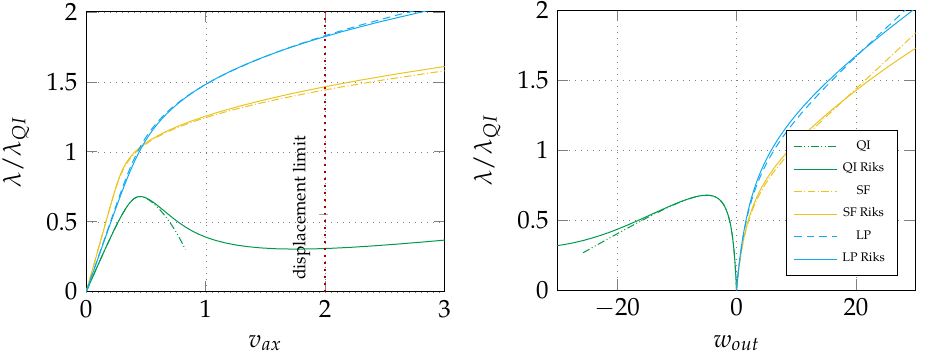
Figure 5. Comparison of the equilibrium paths obtained using Koiter’s method with Riks results. On the left, the axial displacement ( v ax ) is plotted while, on the right, we have the out-of-plane displacement at the panel center ( w out ). Baseline QI case, straight fibre design [26] and optimal lamination parameters are